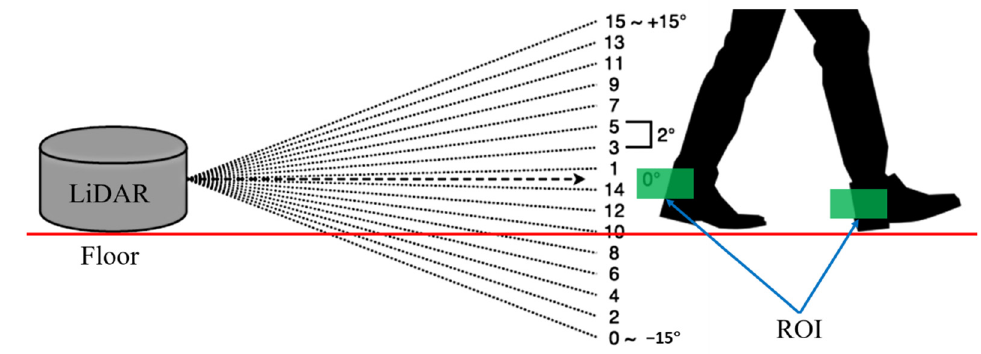
Figure 3. Selected LiDAR laser ID in line with the region of interest of the subject’s ankle area.